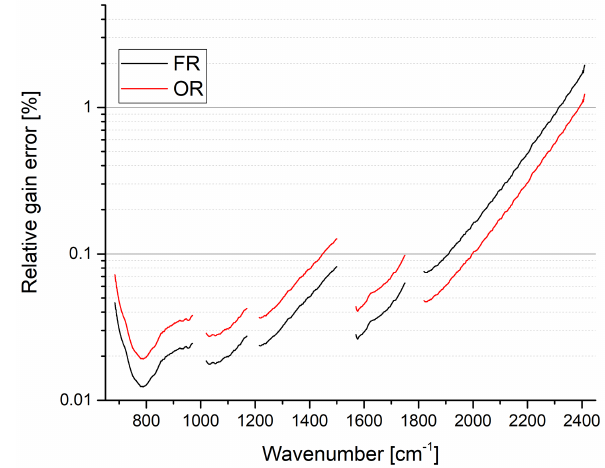
Figure 4. NESR values in the middle of each band throughout the mission. Again, the values measured in FR mode (2002 to 2004) have been scaled to the spectral resolution of the OR mode.